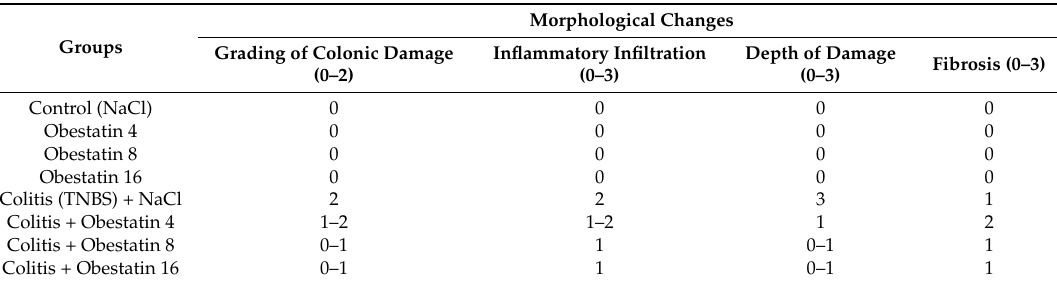
Table 1. Influence of treatment with obestatin given intraperitoneally at doses of 4, 8, or 16 nmol/kg, and colitis evoked by rectal enema with trinitrobenzene sulfonic acid (TNBS) on morphological signs of colonic damage, observed 14 days after induction of